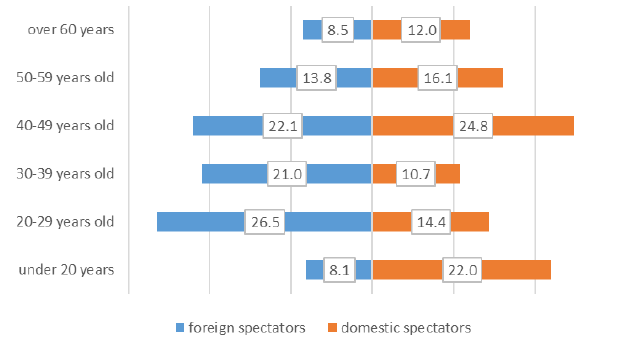
Figure 2 . Age Distribution of Domestic and Foreign Spectators at the WTTC